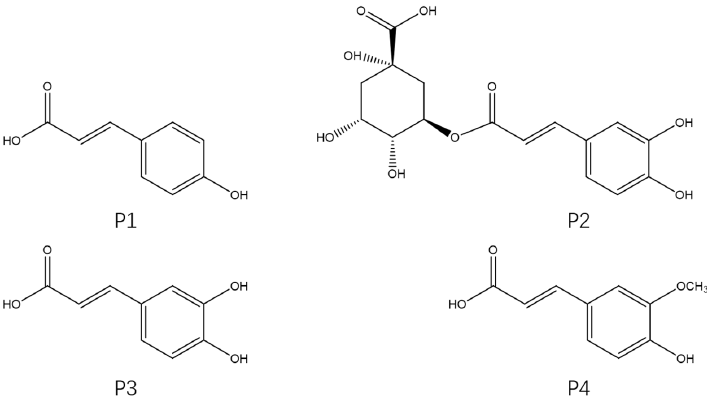
Figure 1. Chemical structures of the four phenylpropanoids from Hippophae rhamnoides